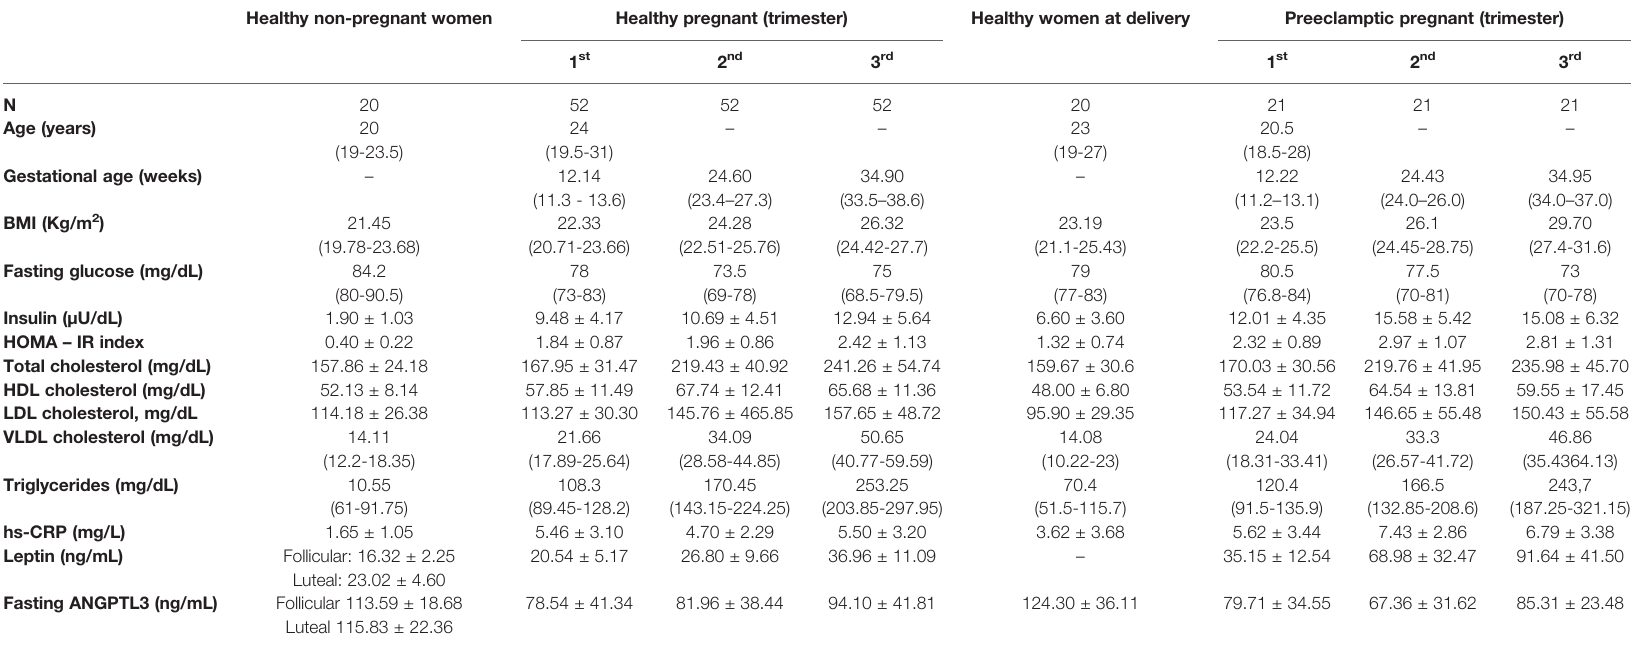
TABLE 1 | Characteristics of healthy non-pregnant women, healthy pregnant women and preeclamptic pregnant